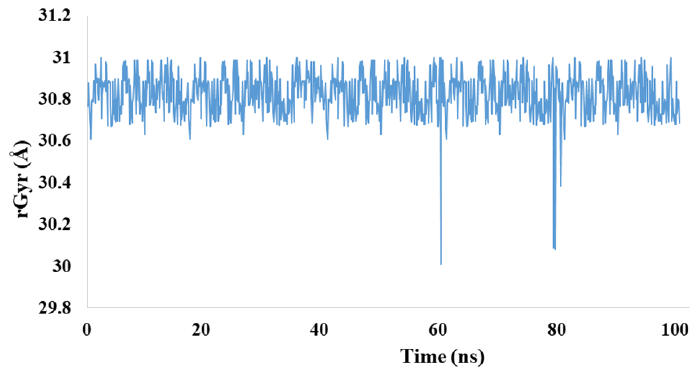
Figure 9. Radius of gyration [rGyr] graph of Urease- 4i complex at 100 ns.